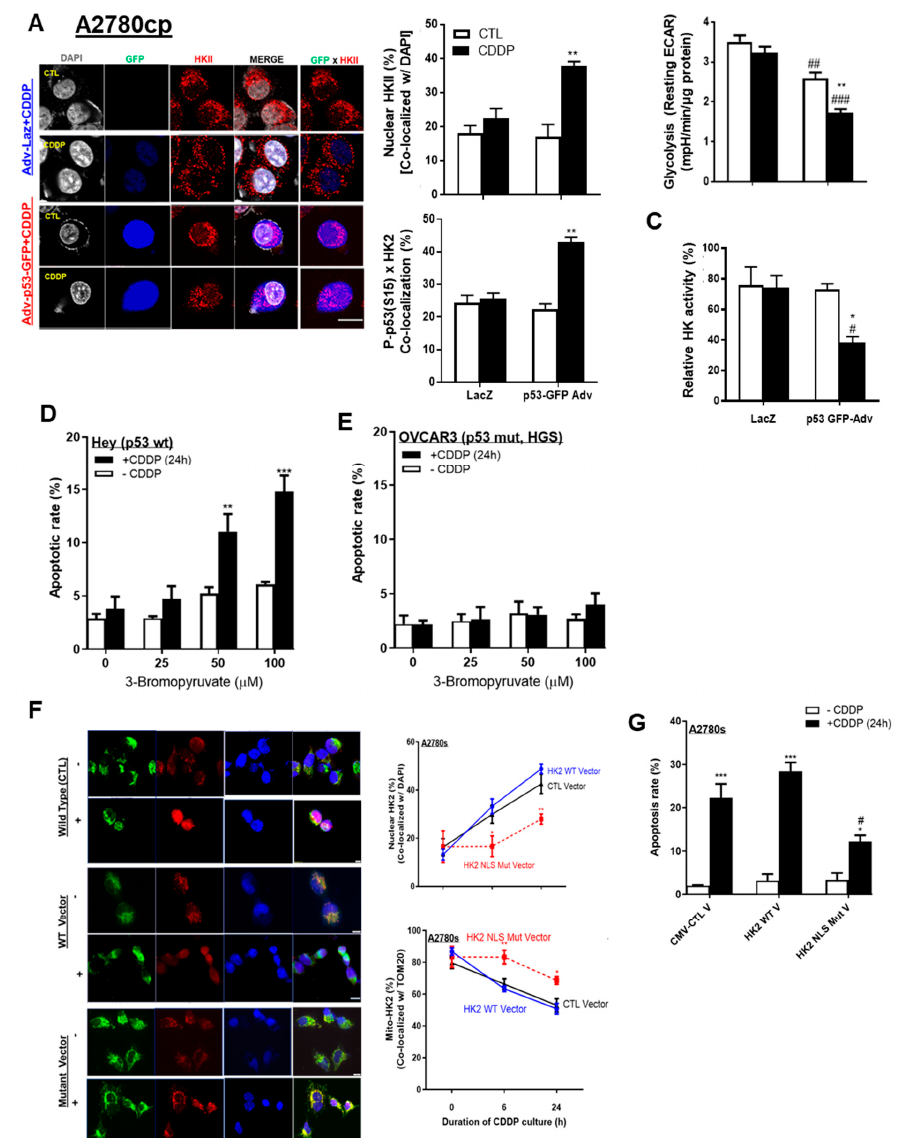
Figure 4. p53 and HKII NLS together are required for intracellular HKII trafficking. ( A ) A2780cp cells were transfected with either adenoviral construct (Adv)–LacZ (multiplicity of infection (MOI) = 1.0; 12 h), or Adv–p53 with GFP tag (MOI = 1.0; 12 h) and cultured with CDDP (0–10 µ M; 24 h; DMSO as vehicle). Cellular localization of HKII (red; as % of total cells), P-p53 with GFP tag (blue), and DAPI (grey) was examined by confocal microscopy and quantified. ( B ) Glycolysis (resting ECAR) was measured using an XF96e Extracellular Flux Analyzer, while ( C ) HK activity was measured using cell lysate from A2780cp cells treated as described in ( C ). ( D ) Hey (p53 WT) and ( E ) OVCAR-3 (p53 WT) OVCA cells (HGS subtype) were pretreated with 3-bromopyruvic acid (3-BP; 6 h) and treated with CDDP (10 µ M, 24 h) without changing the medium, followed by assessment of apoptosis with Hoechst nuclear staining. ( F ) A2780s cells were transfected with control CMV vector, HKII WT, and HKII NLS mutant vector (2.0 µ g; 24 h). Transfected cells were seeded in 8-chamber slides and cultured with CDDP (0–10 µ M; 24 h; DMSO as vehicle), followed by fixation for immunofluorescence (IF). Cellular localization of HKII (red; as % of total cells), TOM 20 (green), and DAPI (blue) was examined via IF microscopy (400 × ) and quantified. ( G ) Cells were treated as described and subjected apoptosis assessment. Scale bar: 10 µ m. Error bars denote ± SEM ( n = 4). (* p < 0.05, ** p < 0.01, *** p < 0.001, HKII CTL CMV vector vs. HKII NLS mutant vector) (Figure 4E: * p < 0.05, ** p < 0.01, CTL vs. CDDP; # p < 0.05, ## p < 0.01, ### p < 0.001, HKII CTL CMV vs. HKII NLS mutant). Scale bar: 10 µ